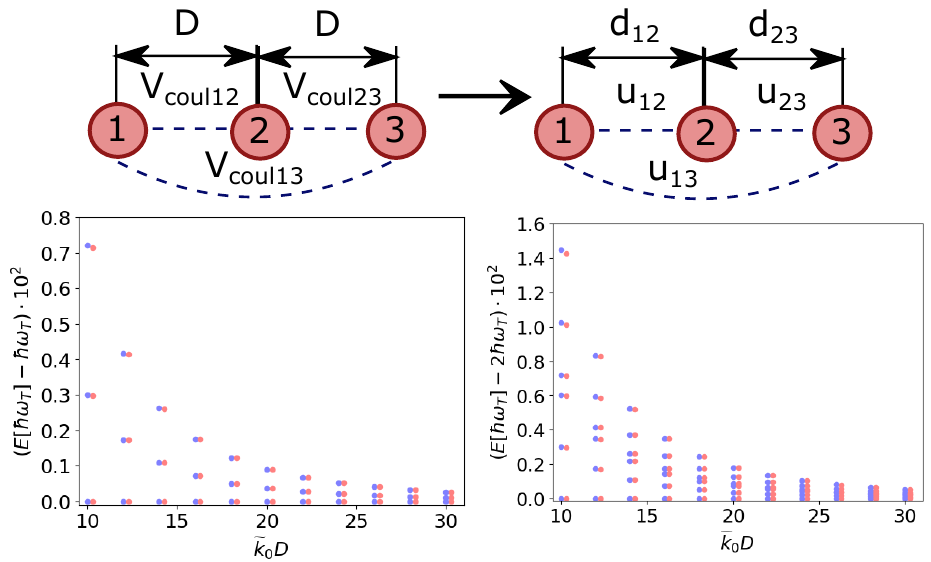
Figure 2. Schematic mapping of three ions along a line, interacting via the Coulomb force separated at a distance D onto a system of particles along a nanofiber, with distances d 12 and d 23 . This can be achieved by finding the right distances, frequencies and interactions strengths to solve Equations (16). The lower figures show the eigenenergies of these three harmonically trapped ions with Coulomb repulsion (blue) in comparison to particles trapped along the fiber with simulated interaction (red) as a function of the distance between the interacting particles. In the simulation, the particles are trapped along the fiber at fixed distances d 12 = d 23 = 3/8 λ 0 and the pump laser parameters are adjusted to mimic Coulomb interaction at arbitrary distances between the ions. We used ∆ k = 0.7 k 0 and Ω Ω = 0.34 + 1.07 (cid:101) k Ω Ω = 1.16 + 1.34 (cid:101) k Ω Ω = 1.68 + 1.58 (cid:101) k Ω Ω = 0.74 + 1.4 (cid:101) k 0 / (cid:101) 0 D , 0 D , 2 / (cid:101) 0 D , 3 / (cid:101) 0 D , 1 / (cid:101) with (cid:101) k 0 = k 0 δ 0 / δ (cid:48) . For this figure, we chose (cid:101) Ω / ω T , such that every Ω l / ω T ≤ 0.004 is restricted as 0 required by Equation (11), that is, (cid:101) Ω / ω T = max l ( Ω l / (cid:101) Ω ) / ( 0.004 (cid:101) k 0 D ) 3 . The figure on the left side shows the energies corresponding to the first oscillator state and the right figure shows the energies corresponding to the second oscillator